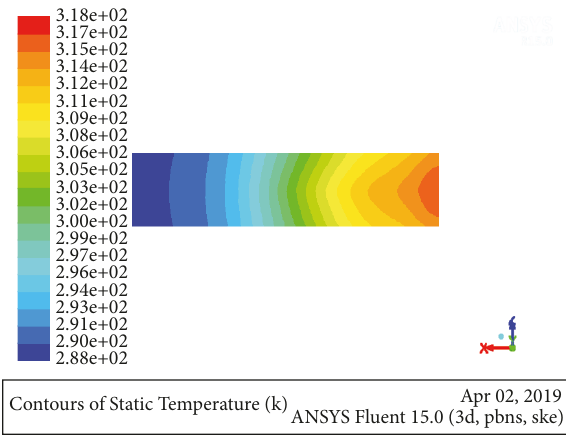
Figure 25: The bottom temperature distribution of support in Test